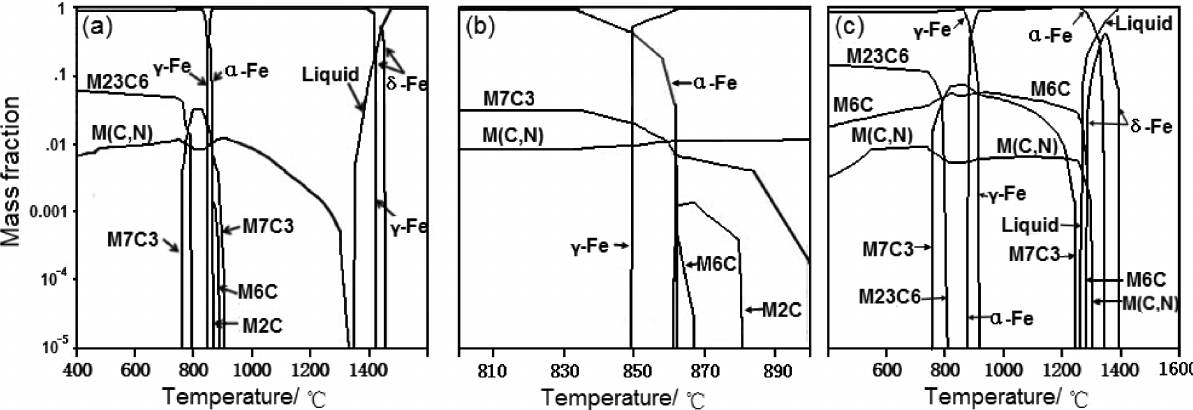
Fig. 3: Thermodynamic calculation of carbides in H13. (a) 400–1600 °C; (b) 800–900 °C; (c) simulated calculation of the segregation